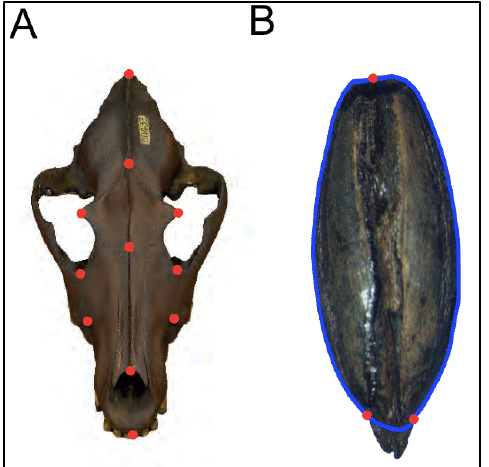
Figure 1. Example of geometric morphometric protocols applied to bioarchaeological remains. A Example of Procruste approaches used to quantify the morphometric variation of canid skulls with 3D landmarks. B Example of protocols for 2D outline analyses used to quantified the morphometric variation of barley